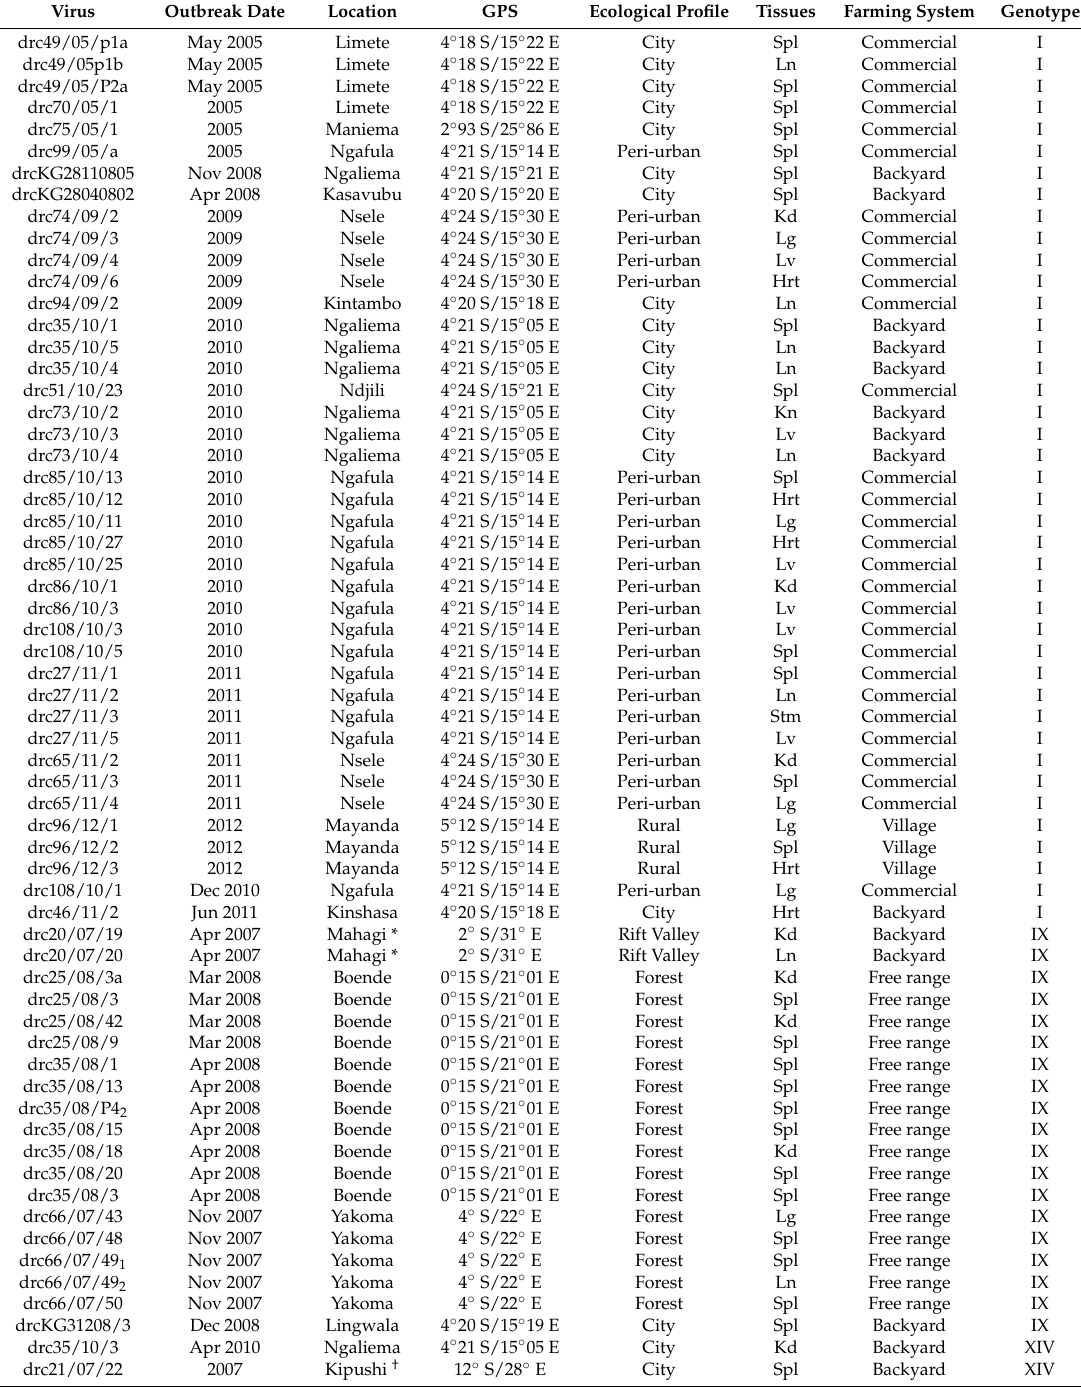
Table 1. Samples, details, and